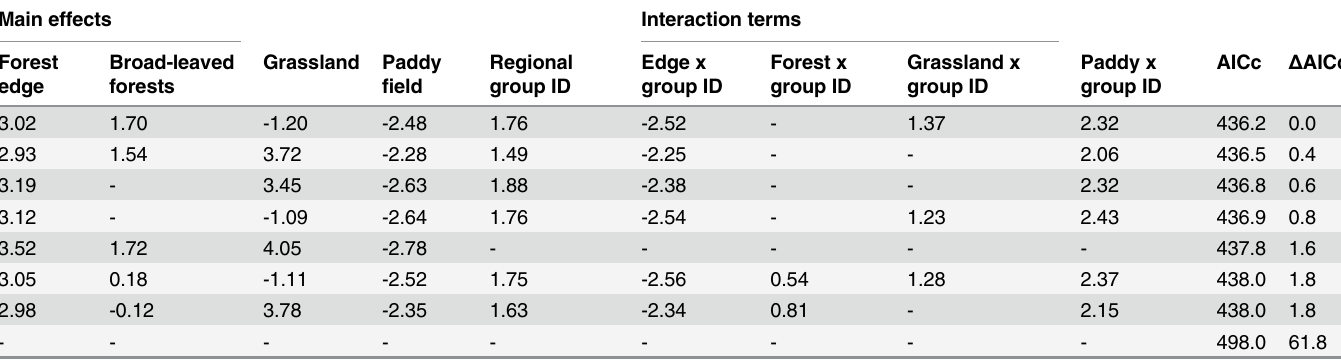
Table 5. Selected models for 2 regional-groups based on landscape similarity (Aichi and others) to explain relationships between buzzard occur- rence and landscape